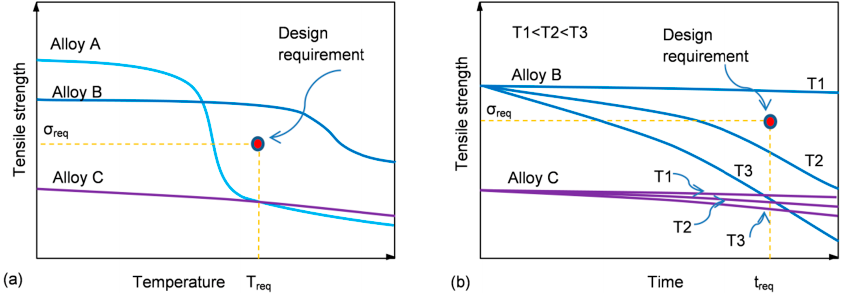
Figure 3. Thermal stability of structural materials and design requirements: ( a ) schematics of hypothetical changes in tensile strength versus temperature ( b ) and strength versus time at constant temperature ( b ), along with the strength required σ req at temperature T req during service time t req.